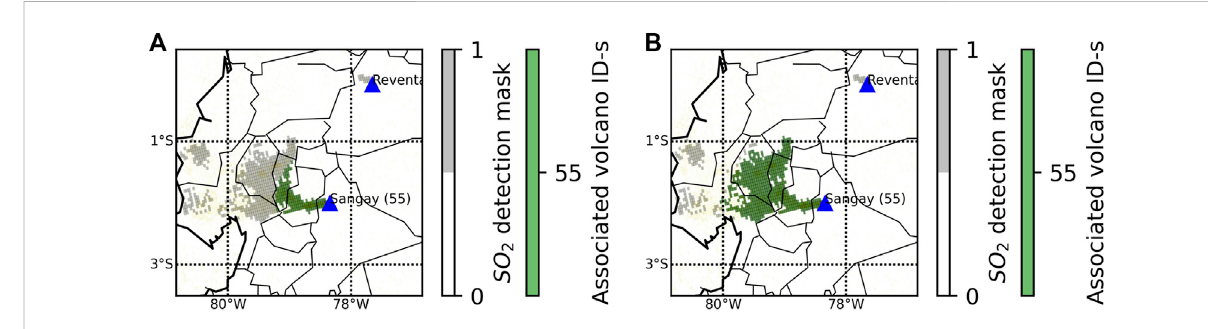
FIGURE 7 Comparison of two basic binary classi fi cations (Sangay volcano, on 15.08.2021). (A) Radius search classi fi er. (B) Flood- fi ll classi fi er.